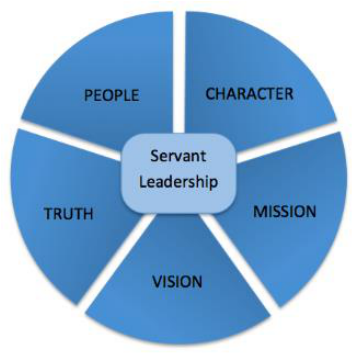
Figure 4. Servant leadership at Nuru